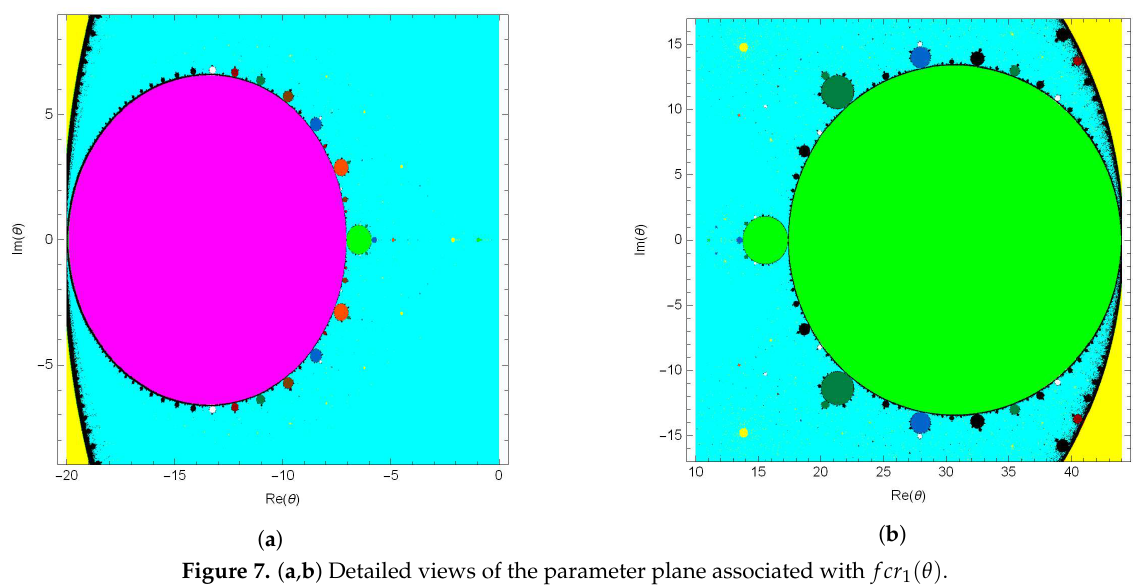
Figure 7. ( a , b ) Detailed views of the parameter plane associated with fcr 1 ( θ ) .